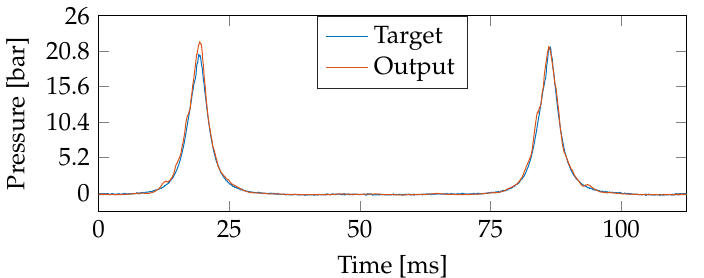
Figure 7. Time courses of the TDNN prediction for an unseen test subset. The target and output pressure prediction are presented for the following set-up: engine running at 2400 RPM with 0.45 BMEP load. The time delay is fixed as 100 ms.